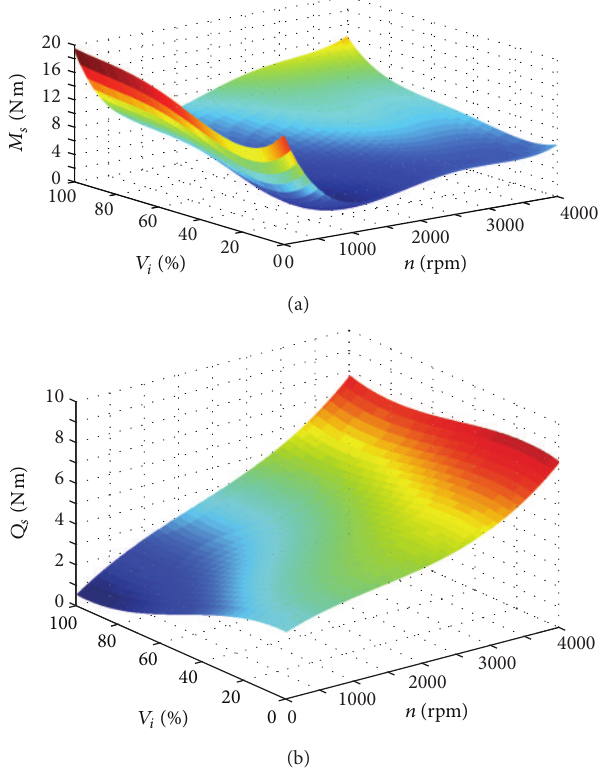
Figure 8 redraws the principle of the SHT control cylin- der. Newton’s second law is used to obtain the force balance equation.